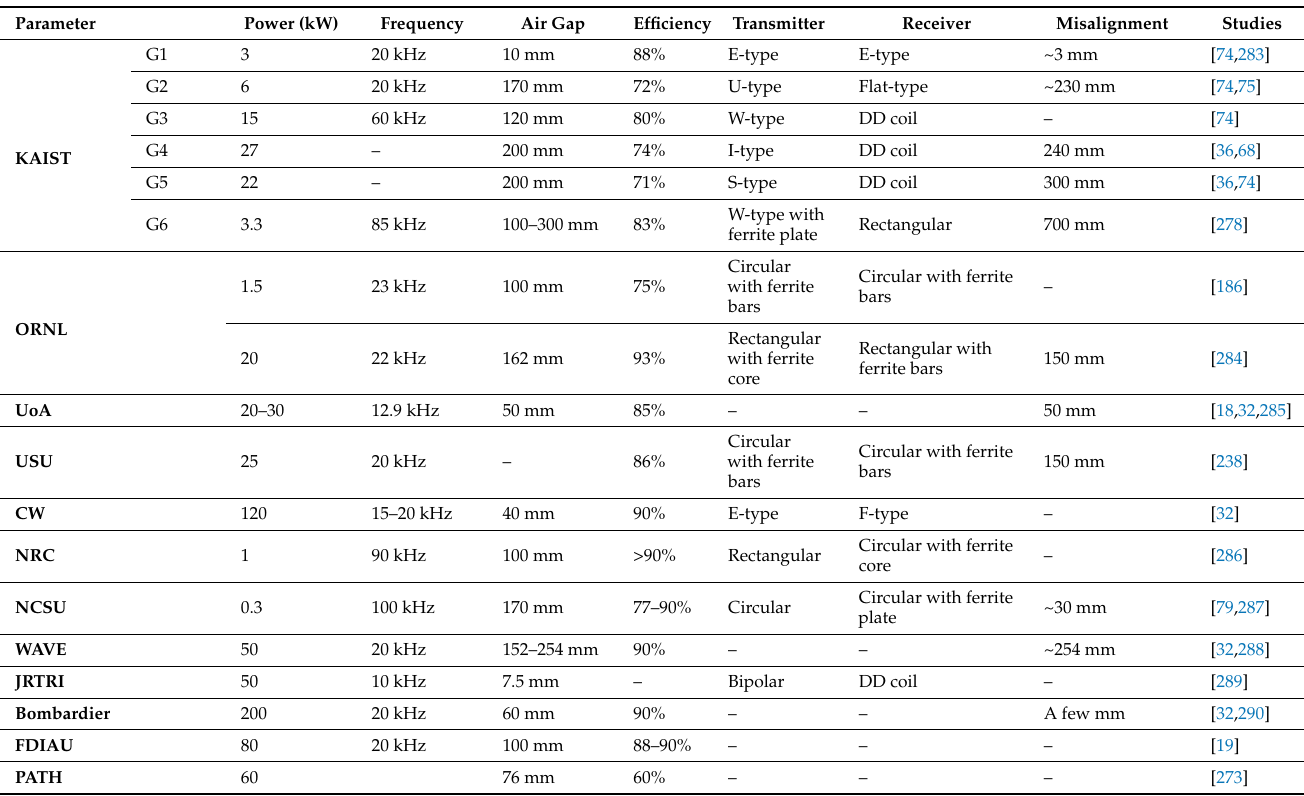
Table 15. Summary of R&D for DIPT